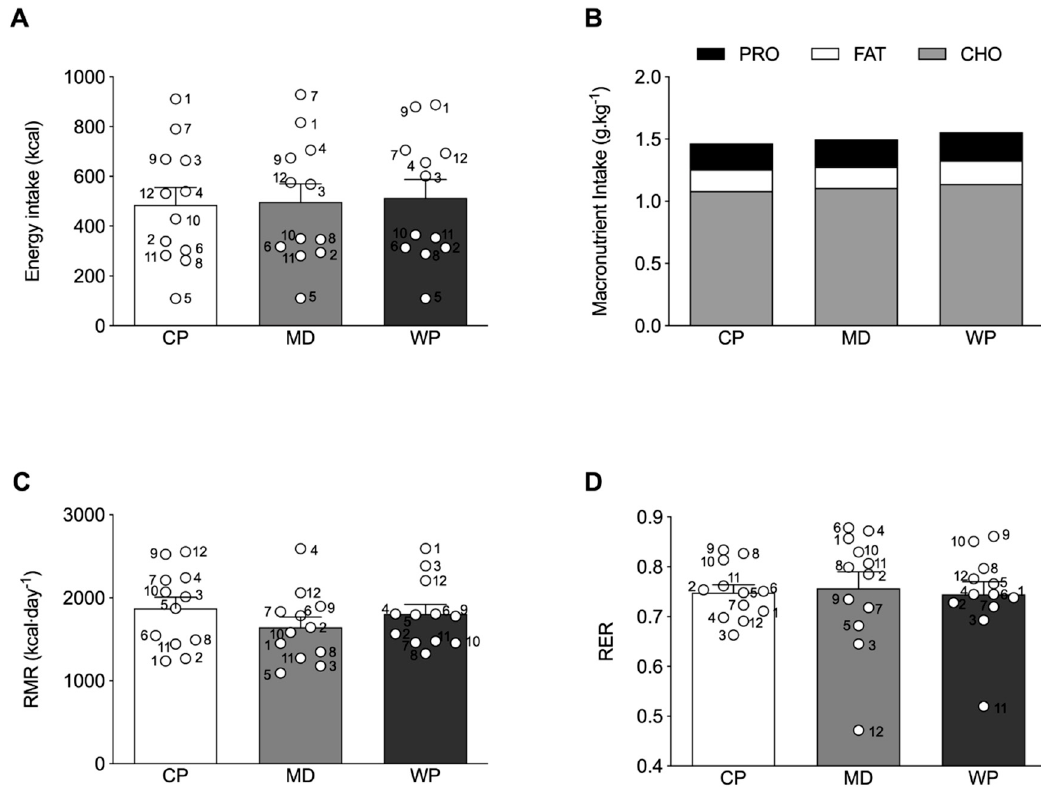
Figure 3. ( A ) Absolute total energy intake and ( B ) relative macronutrient intake at the ad libitum breakfast. ( C ) resting metabolic rate (RMR) and ( D ) respiratory exchange ratio (RER) as measured by indirect calorimetry. ○ represent individual values within each experimental trial, subject numbers are placed adjacent to the corresponding circle. Figures represent mean values with SEM.